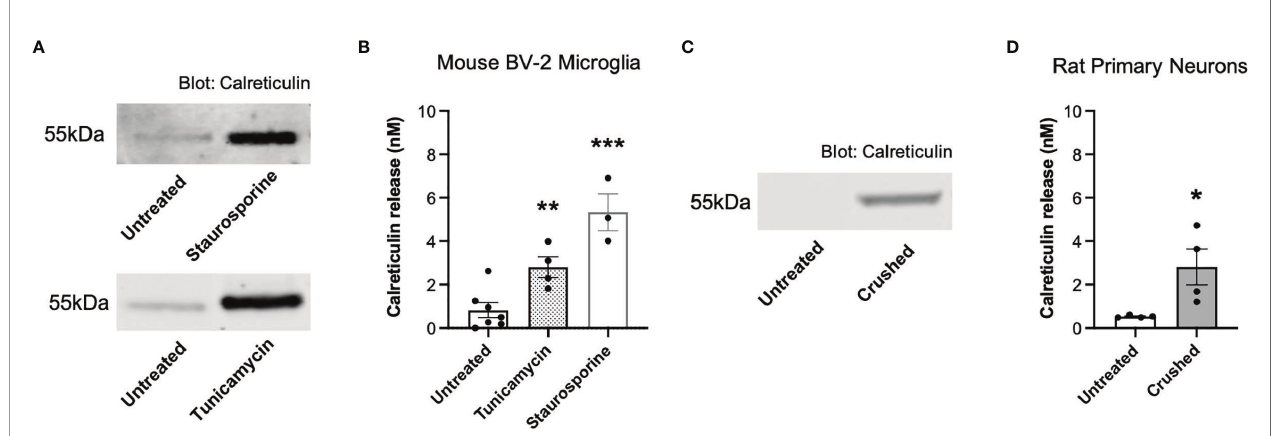
FIGURE 1 | Calreticulin is released from ER-stressed and dying microglia, as well as crushed neurons. (A, B) Calreticulin release from mouse BV-2 microglia treated with tunicamycin (2 µg/mL) or staurosporine (1 µM) for 20 hours, measured by western blots. (A) Representative blots. (B) Calreticulin release from treated BV-2 microglia for all experiments. (C, D) Calreticulin release from rat primary neurons before and 1 minute after applying mechanical stress (crushing), measured by western blot. (C) Representative blot. (D) Calreticulin release from crushed rat primary neurons for all experiments. Calreticulin release was quanti fi ed by cross- examining densitometry values of western blot bands to internal recombinant calreticulin standard curves. Data presented as mean calreticulin release values, with error bars representing the SEM of at least 3 independent experiments. Statistical comparisons were made to the untreated control by (B) one-way ANOVA and (D) paired t-test. *p<0.05, **p<0.01,